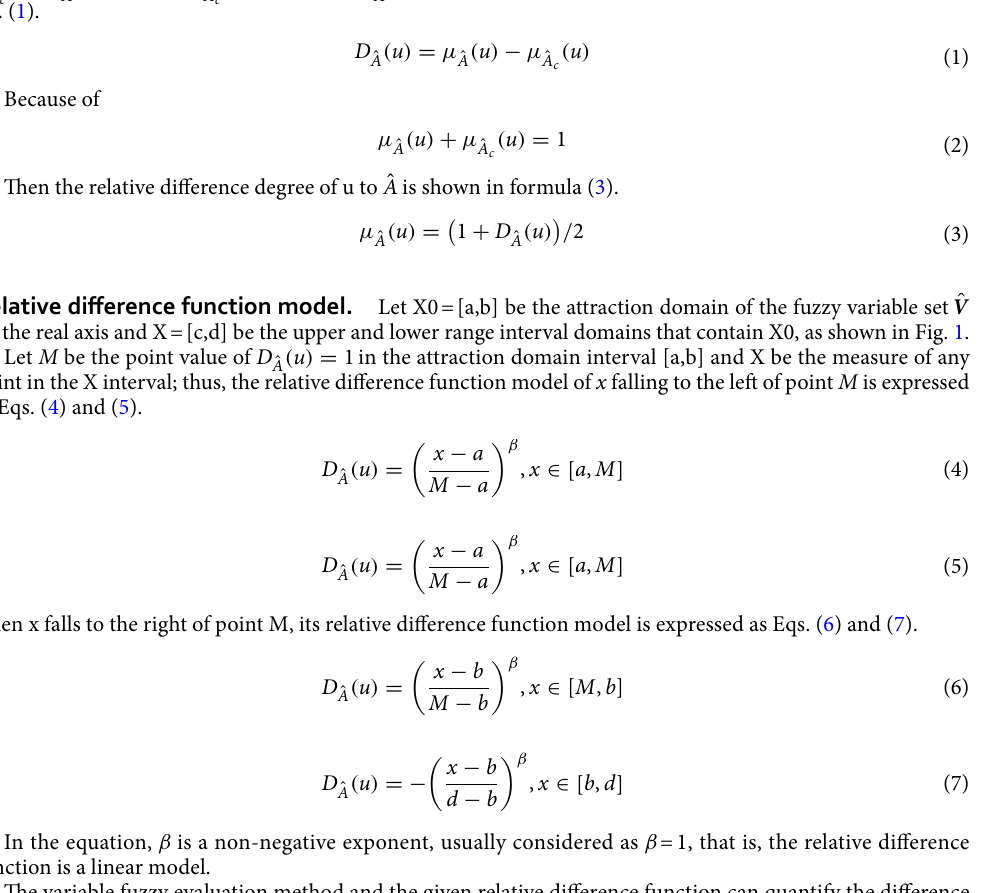
Figure 1. Location diagram of